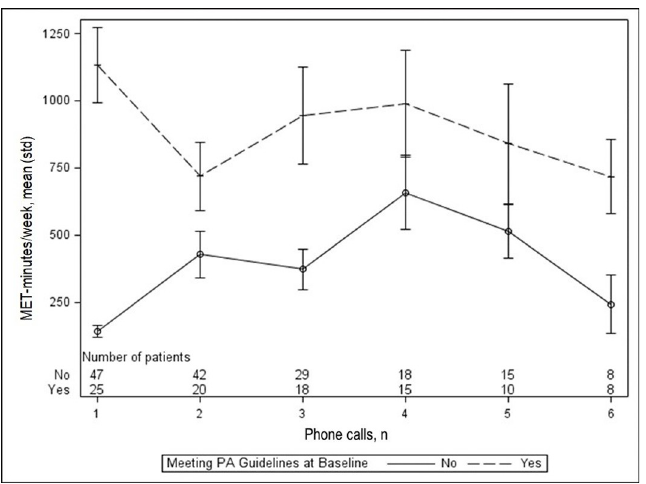
Fig 1. MET-minutes per week, by phone call and meeting vs. not meeting physical activity (PA) guidelines at baseline, n = 72.